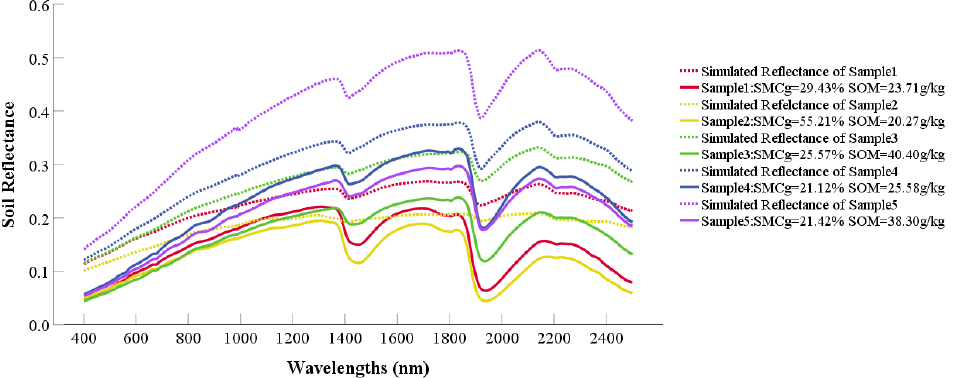
Figure 6. The modeling reflectance and measured reflectance.